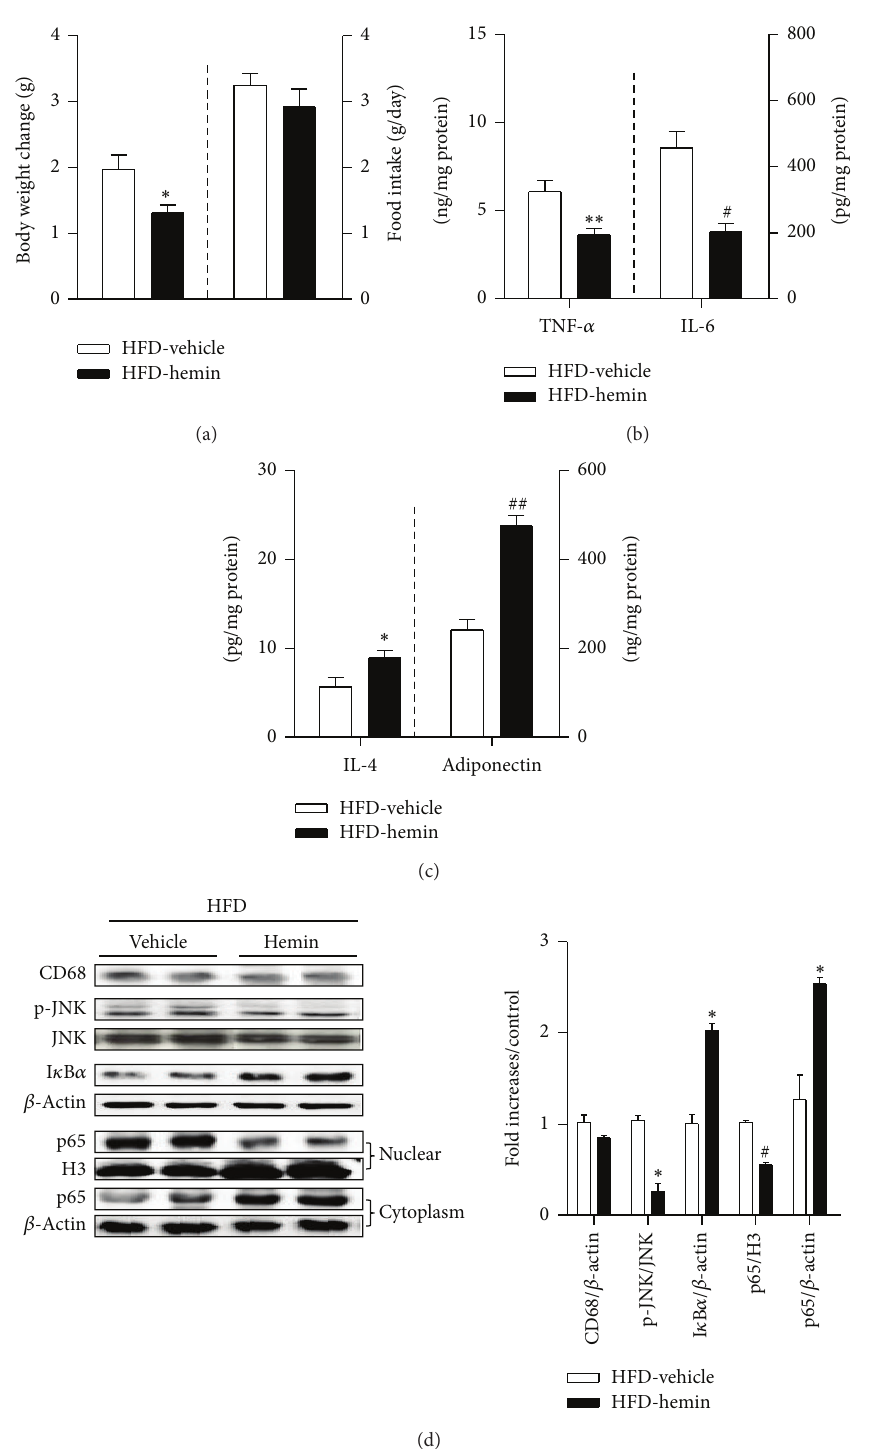
Figure 4: HO-1 induction reduces HFD-induced adipose tissue inflammatory responses. C57BL/6 mice were fed an HFD diet for 2 weeks withhemininjection3timesperweek( 𝑛 = 5 ).(a)Thebodyweightchangeandfoodintakeweremeasured.(b)TNF- 𝛼 ,IL-6levels,and(c)IL-4 and adiponectin levels were measured by ELISA. (d) Expression of a macrophage marker (CD68) and inflammatory molecules (p-JNK/JNK, I 𝜅 B 𝛼 , and NF- 𝜅 B p65) in adipose tissue were detected by western blotting. Results are means ± SEM. ∗ 𝑃 < 0.05 , ∗∗ 𝑃 < 0.01 , # 𝑃 < 0.005 , and ## 𝑃 < 0.001 (compared with HFD-vehicle